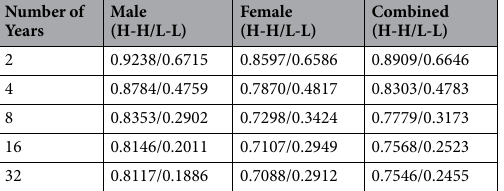
Table 2. Social stratification process over time (year) driven by upward/downward mobility (values presented as probabilities) for males, females, and combined sexes. A Markov process stabilizes when the two diagonal elements (H-H and L-L) asymptotically approach certain values (limiting probabilities). By our operational definition (see the Methods section), the limiting probabilities are reached between 16 and 32 years, approximately the lifespan for males and females as